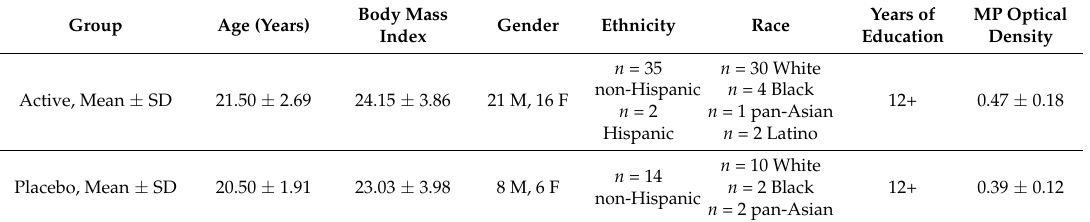
Table 1. Baseline characteristics of placebo participants vs. those on the active supplement.